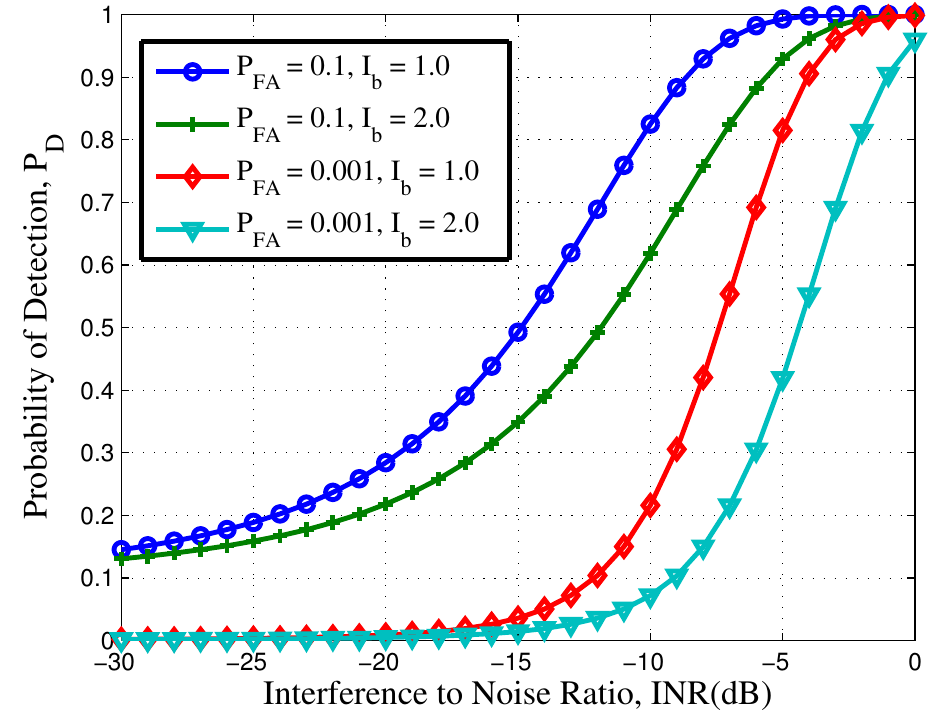
Figure 4. Detection performance and effects of interference